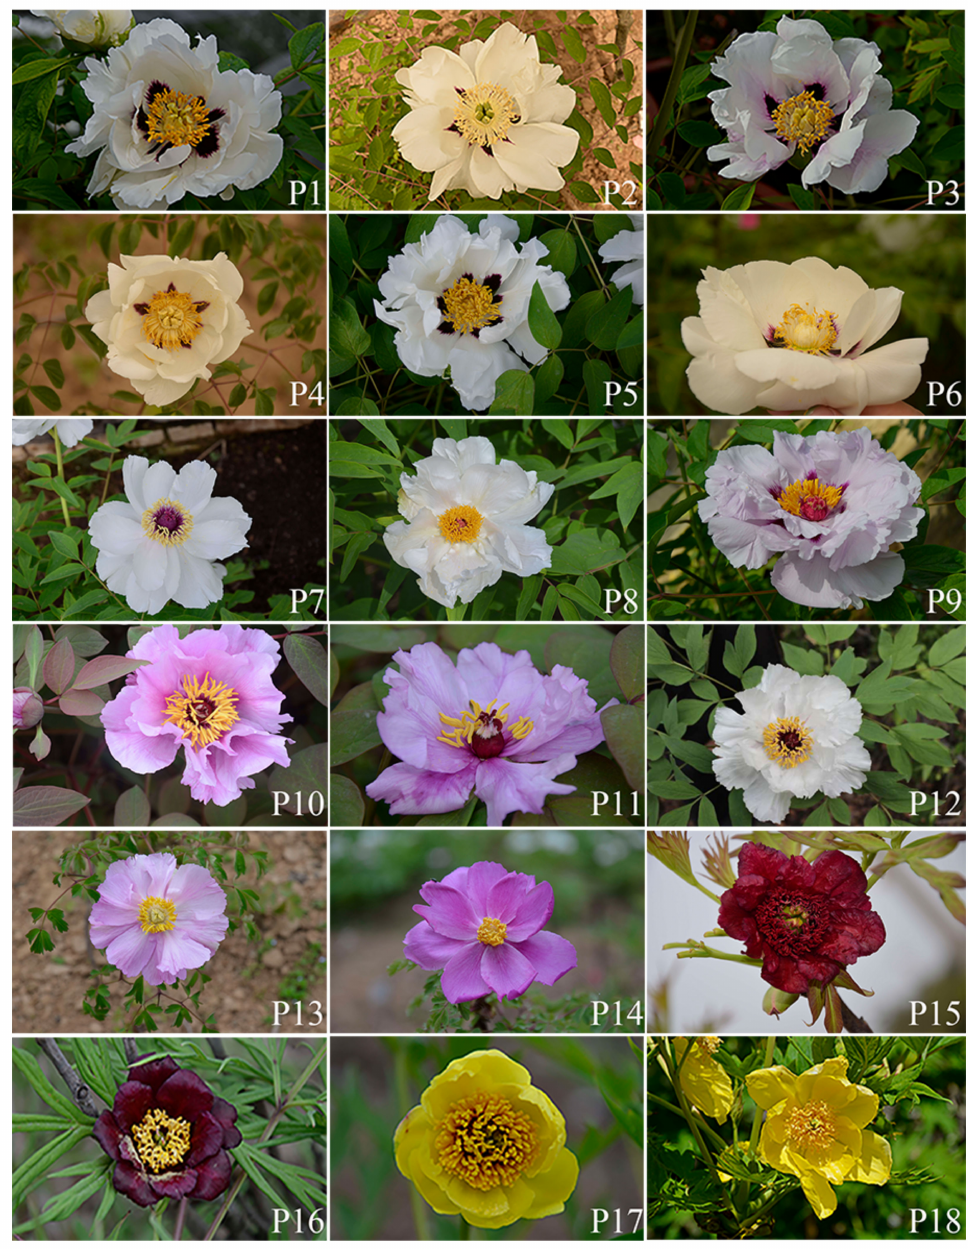
Figure 1. Flowers of nine tree peony species from 18 populations. Population codes refer to Table